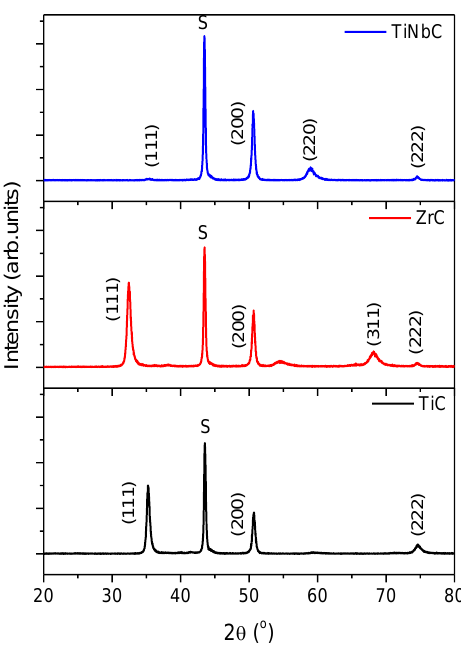
Figure 1. X-ray diffraction (XRD) patterns of the investigated coatings (TiC, ZrC, TiNbC) determined using Cu K α radiation from 20° to 80° with a step size of 0.02°/min. The “S” are peaks related to substrate.